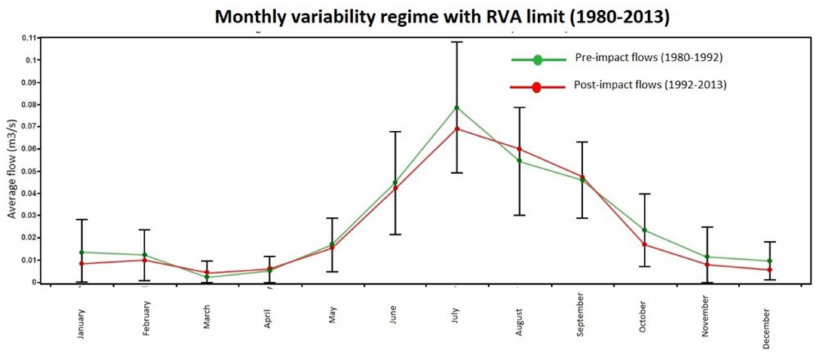
Figure 6. Regime of annual variability, which allows to observe the periods of rain and drought throughout the year.